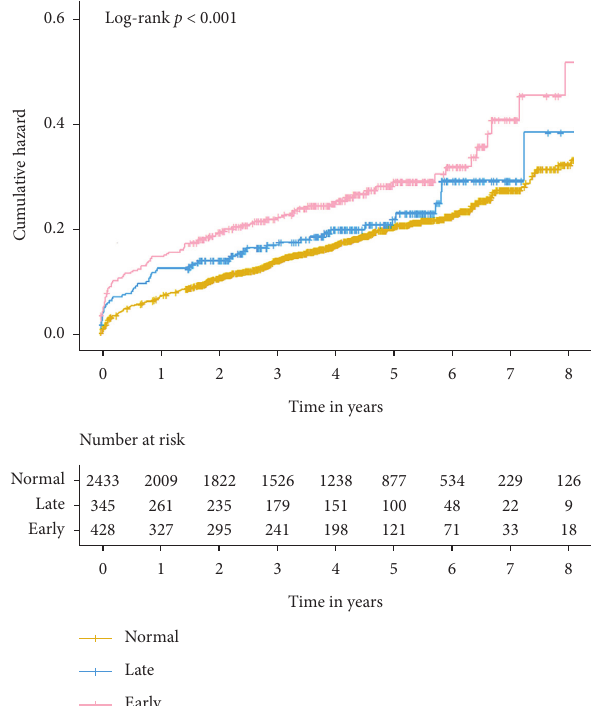
Figure 5: Kaplan–Meier curves for the cumulative probability of mortality stratified according to early CA-AKI, late CA-AKI, and normal. CA-AKI is defined as an increase ≥ 25 or ≥ 0.5mg/dL from baseline.